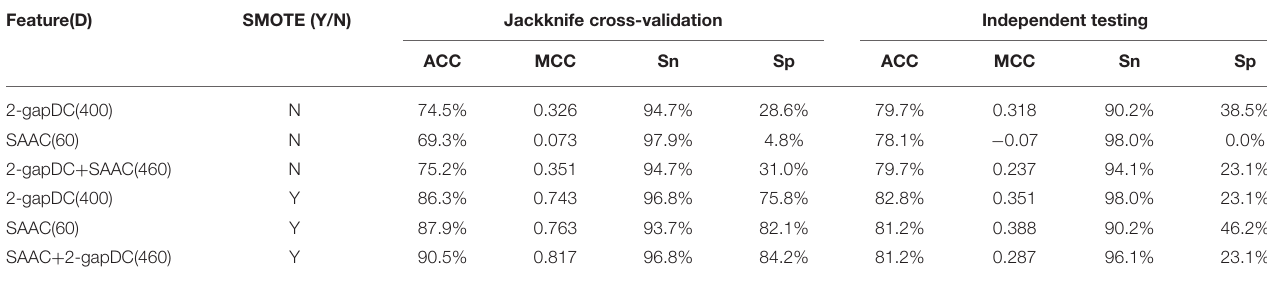
TABLE 1 | Jackknife cross-validation and independent testing results after training on the benchmark data set D1 without feature selection.